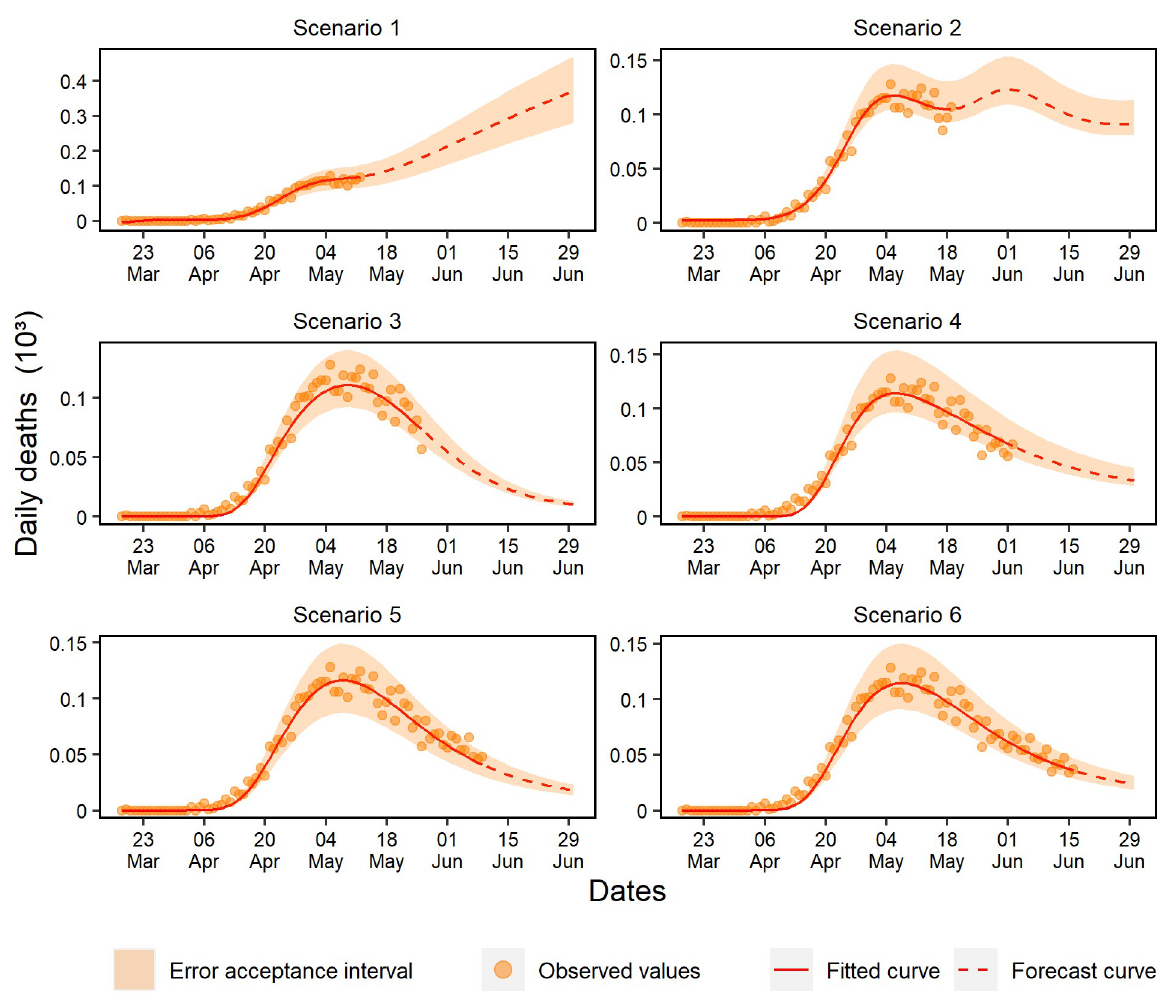
Fig 7. Forecasting of daily deaths in the six analyzed